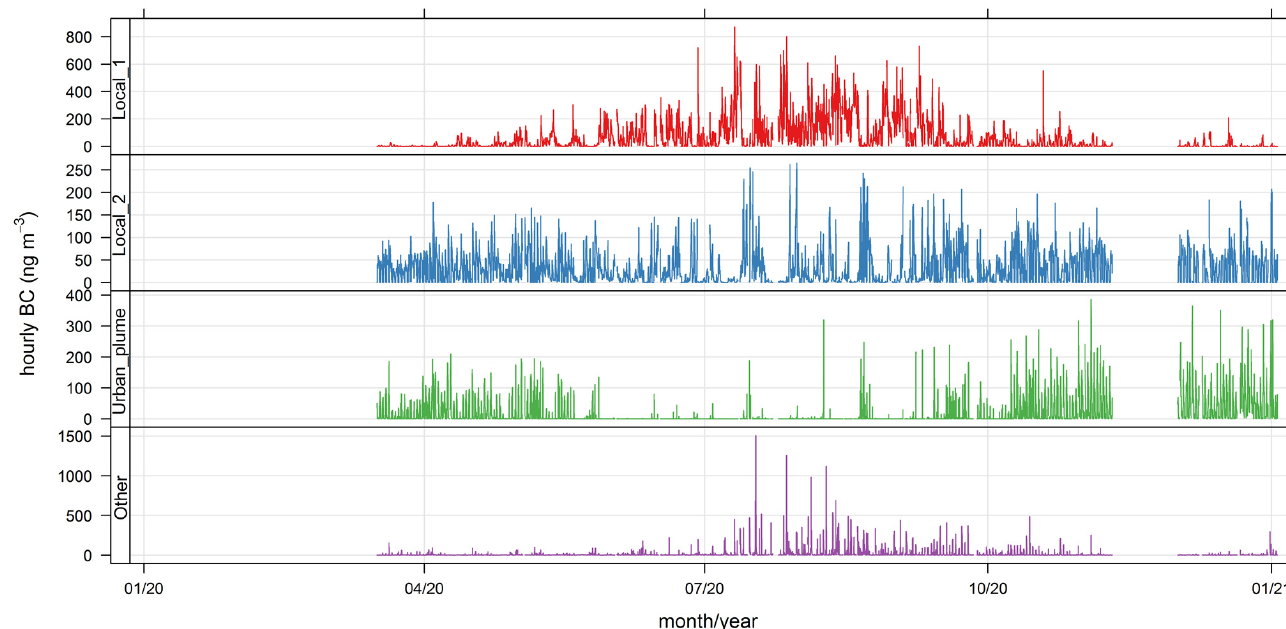
Figure A8. Time series plot of hourly BC ff source contributions, 2020 campaign.